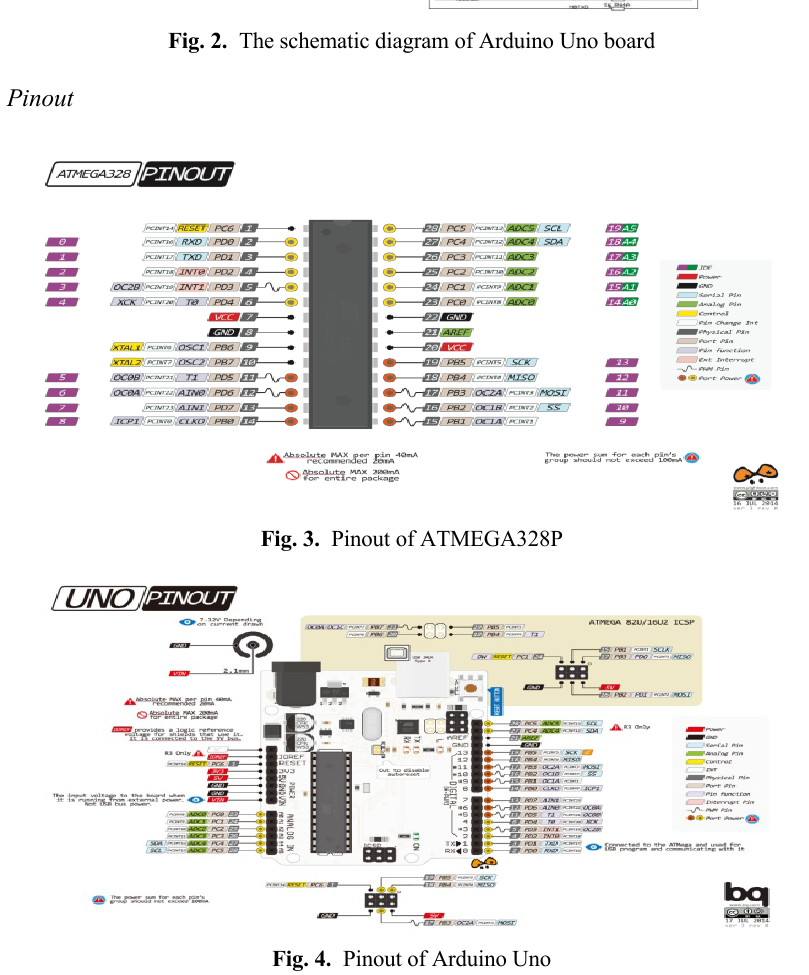
Fig. 4. Pinout of Arduino